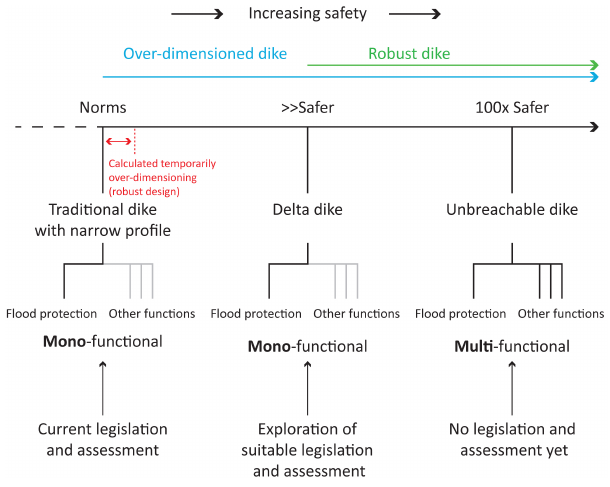
Fig. 1. Visualization of the relation between the various dike con- cepts in the Netherlands; these concepts are described in Table 1.